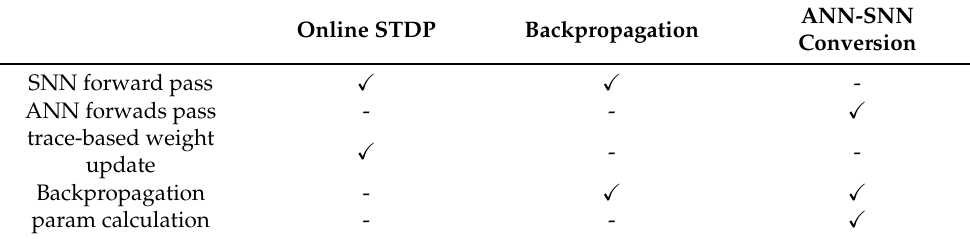
Table 2. SNN learning approaches complexity